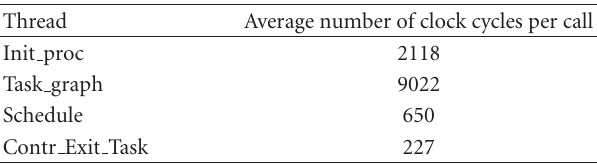
Figure 11: Task graph used for the CAP-OS evaluation: D 1 = 40 ms. Table 6: Timing overhead of CAP-OS for processing TG1.